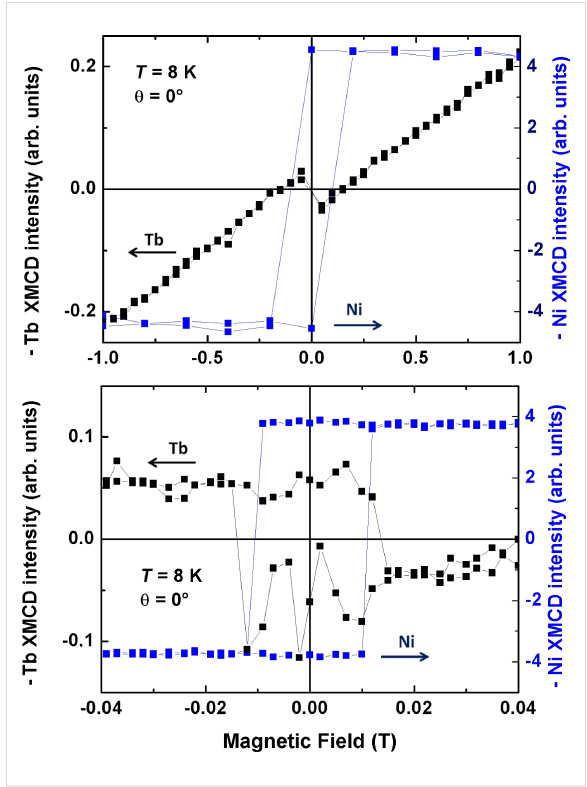
Figure 3: Element-specific field-dependent magnetization for the sample TbPc 2 /Ni/Cu(100). The blue line is the magnetization curve at the maximum XMCD intensity of the Ni L 3 edge (852.5 eV), the black line is at the Tb M 5 edge (1235.4 eV). The top figure shows the curves from − 1 T to 1 T and the bottom figure presents a zoom between − 0.04 T and 0.04 T. The measurements were performed at T = 8 K under normal X-ray incidence